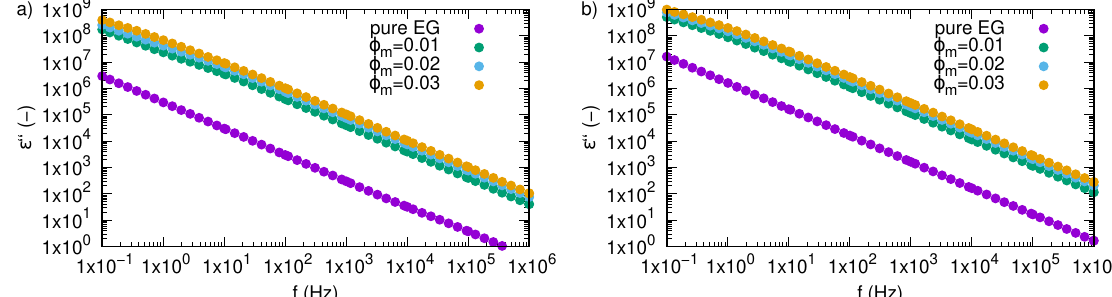
Figure 5. Imaginary part of permittivity, ε ”, of silicon oxide lignin ethylene glycol nanofluids as function of frequency for temperature ( a ) 298.15 K, ( b ) 333.15